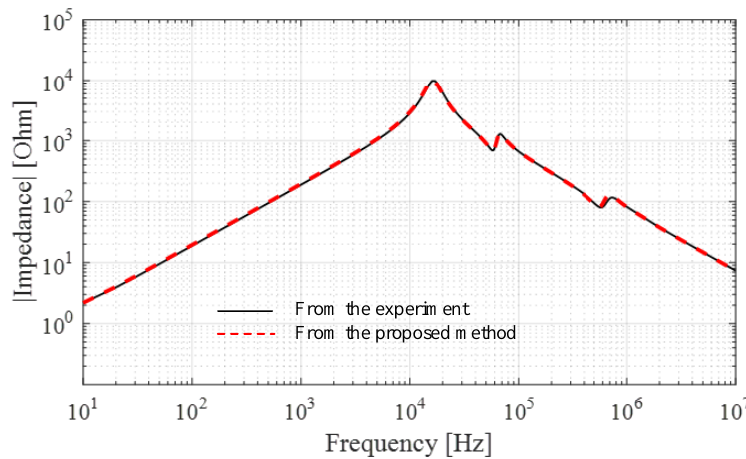
Figure 20. Magnitude of input impedances of the transformer winding from the measurement and the proposed method.